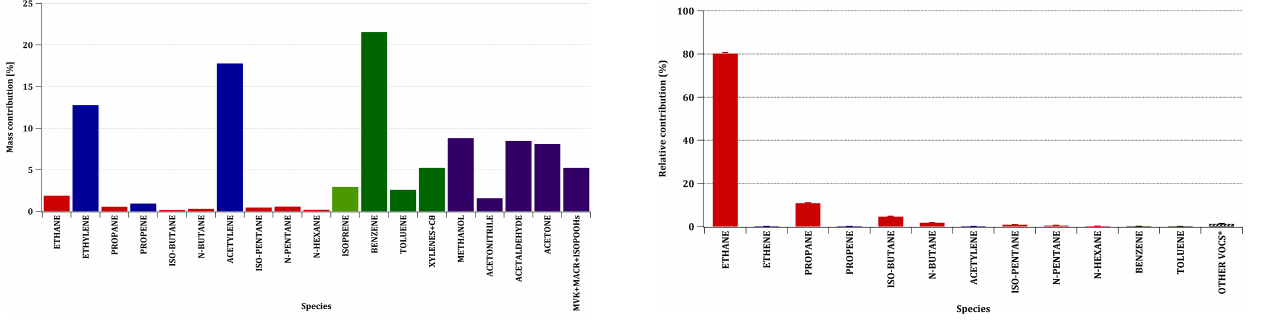
Figure 3. Average VOC fingerprint (in mass contribution, %) from domestic biomass burning obtained during the fireplace experiment. Red, blue, light/dark green and purple bars correspond to alka- nes, alkenes-alkynes, isoprene/aromatics and oxygenated species, respectively.